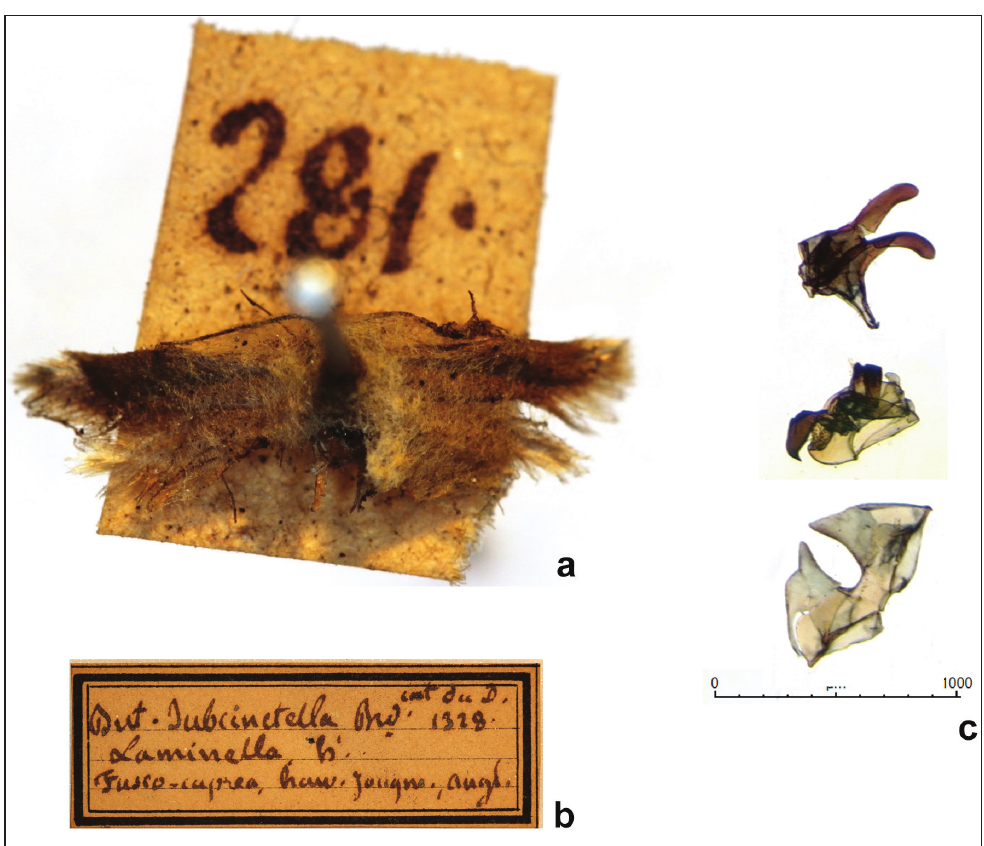
Figure 3. Holotype of Scythris subcinctella (Bruand, 1851), male. a – habitus, wingspan 9.5 mm; b – original label; c –